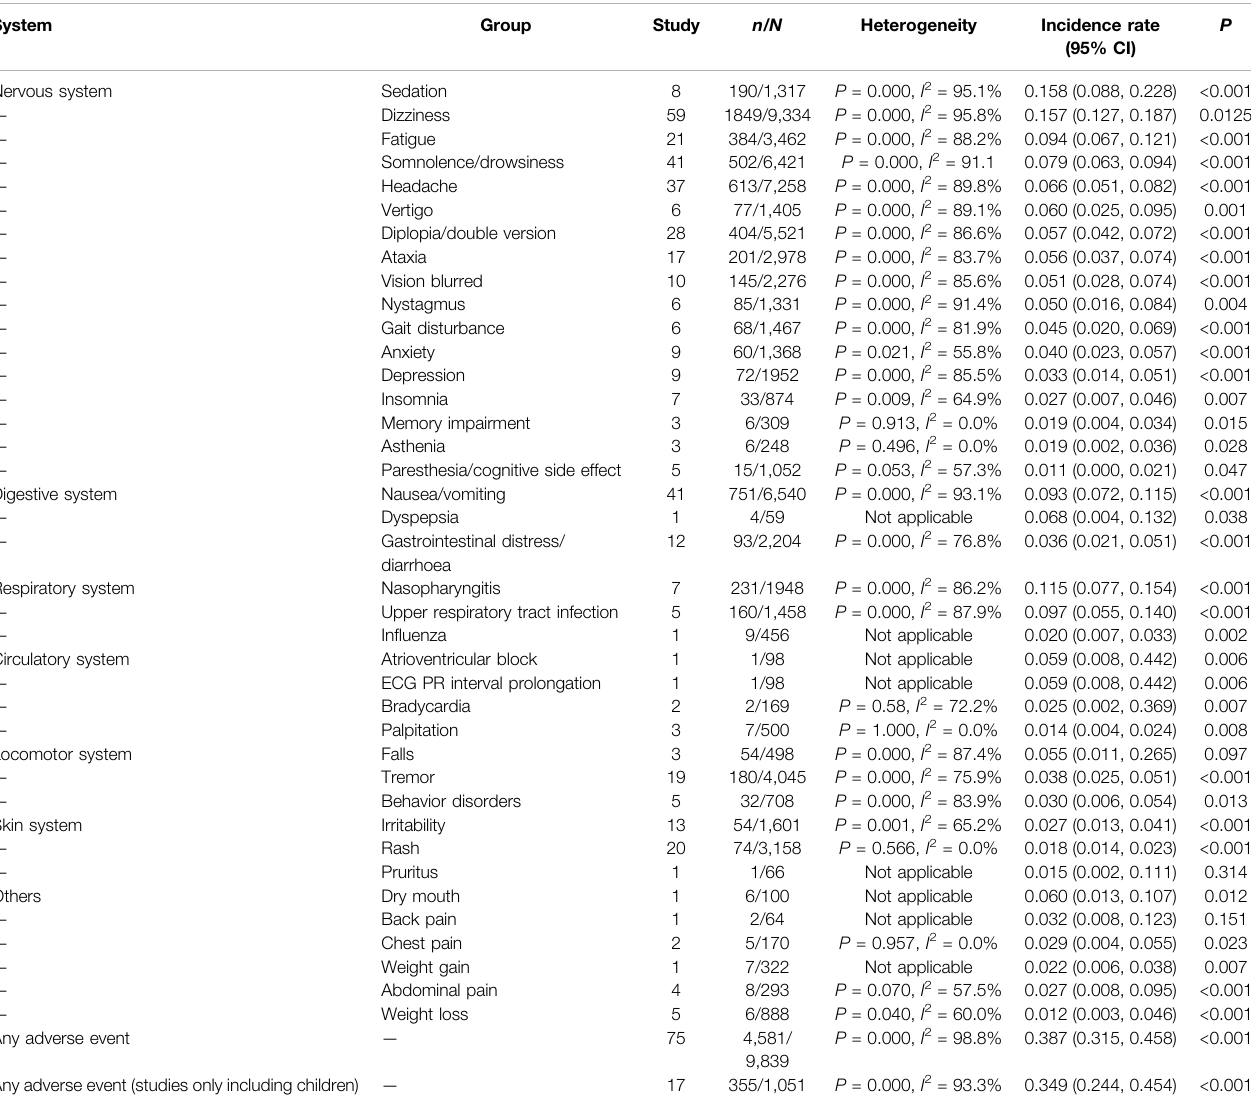
TABLE 1 | Meta-analysis of safety outcomes in different systems.